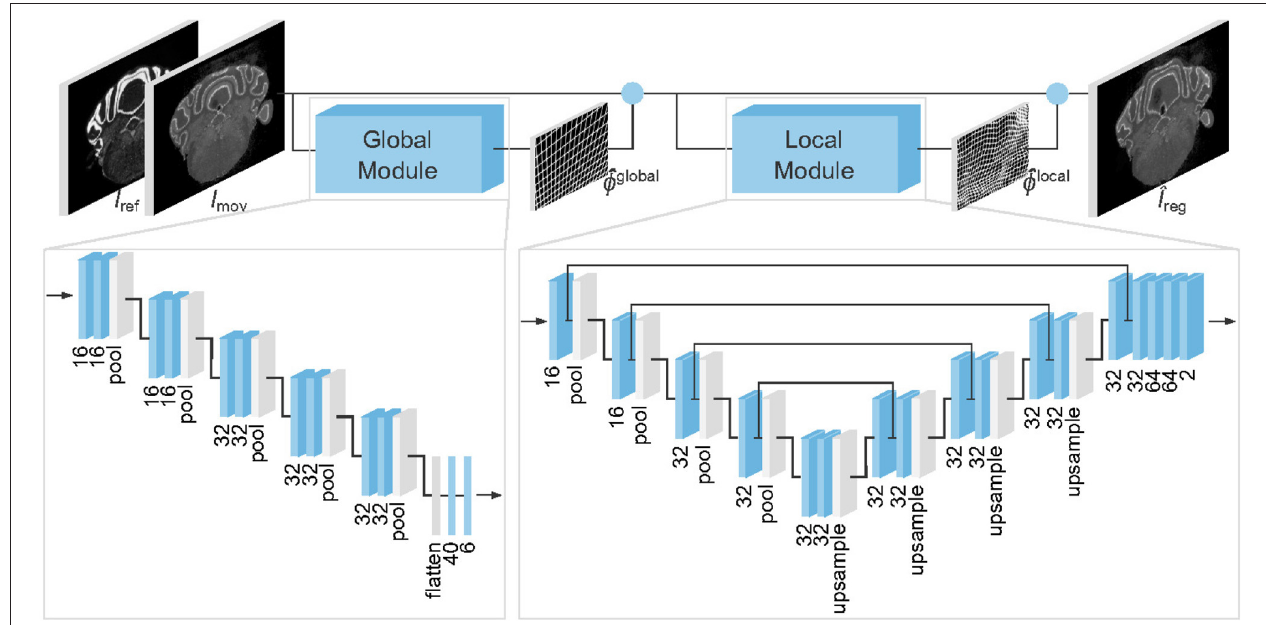
FIGURE 1 | Architecture of the proposed model to register gene expressions I mov to Nissl stains I ref . Blue boxes represent trainable layers. Under all 3 × 3 convolutional layers (3D boxes) and fully connected layers (2D boxes) we display the number of channels and dense units, respectively. Blue circles denote where predicted transformations ˆ φ are